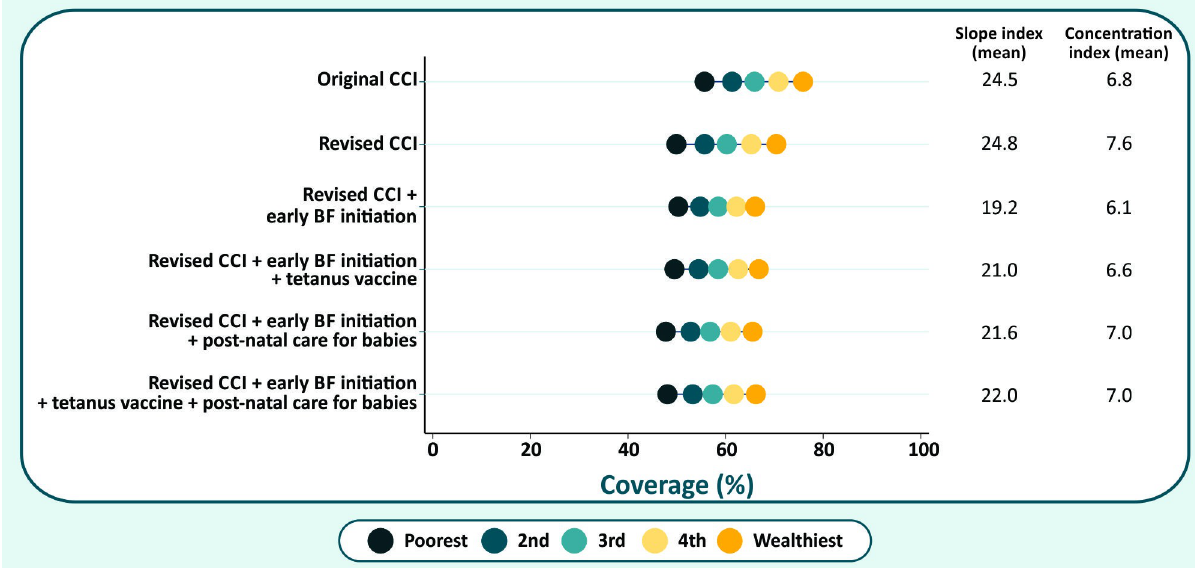
Fig 2. Average values by wealth quintile of the different formulations of the CCI, in 47 countries.